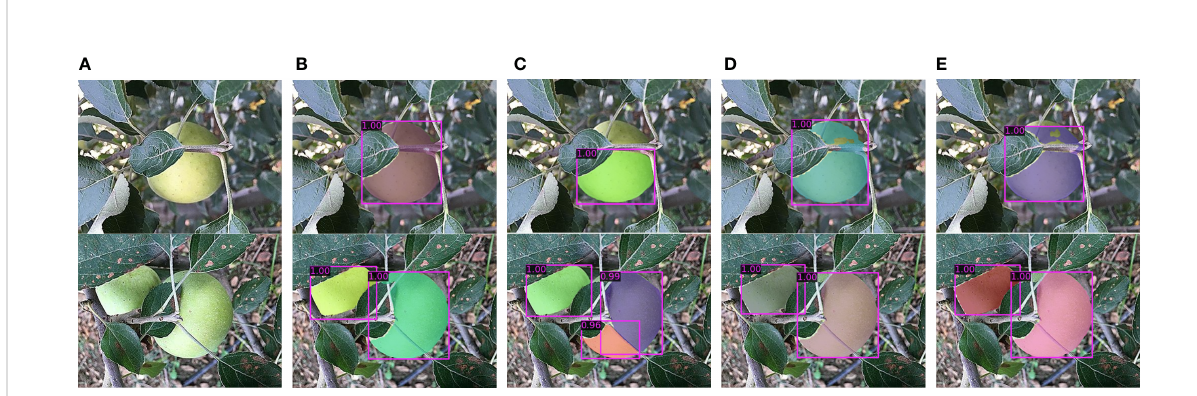
FIGURE 7 Comparison of detection and segmentation results of four methods. (A) Original images. (B) Results of the MS-ADS method. (C) Results of the original Mask Scoring R-CNN (ResNet-50-FPN). (D) Results of the Mask Scoring R-CNN with ResNeSt-50-FPN. (E) Results of the Mask Scoring R-CNN with ResNeSt-50-FPN and improved R-CNN